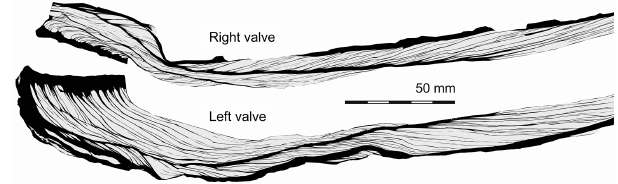
Figure 7. Longitudinal section through C. gryphoides from the oys- ter reef site showing the high amount of chalky layers (gray) and the low amount of foliate layers